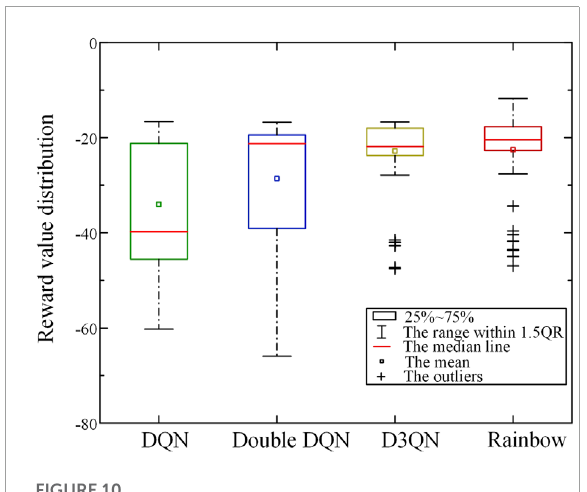
FIGURE 9 Reward value for DQN and its improved algorithm.